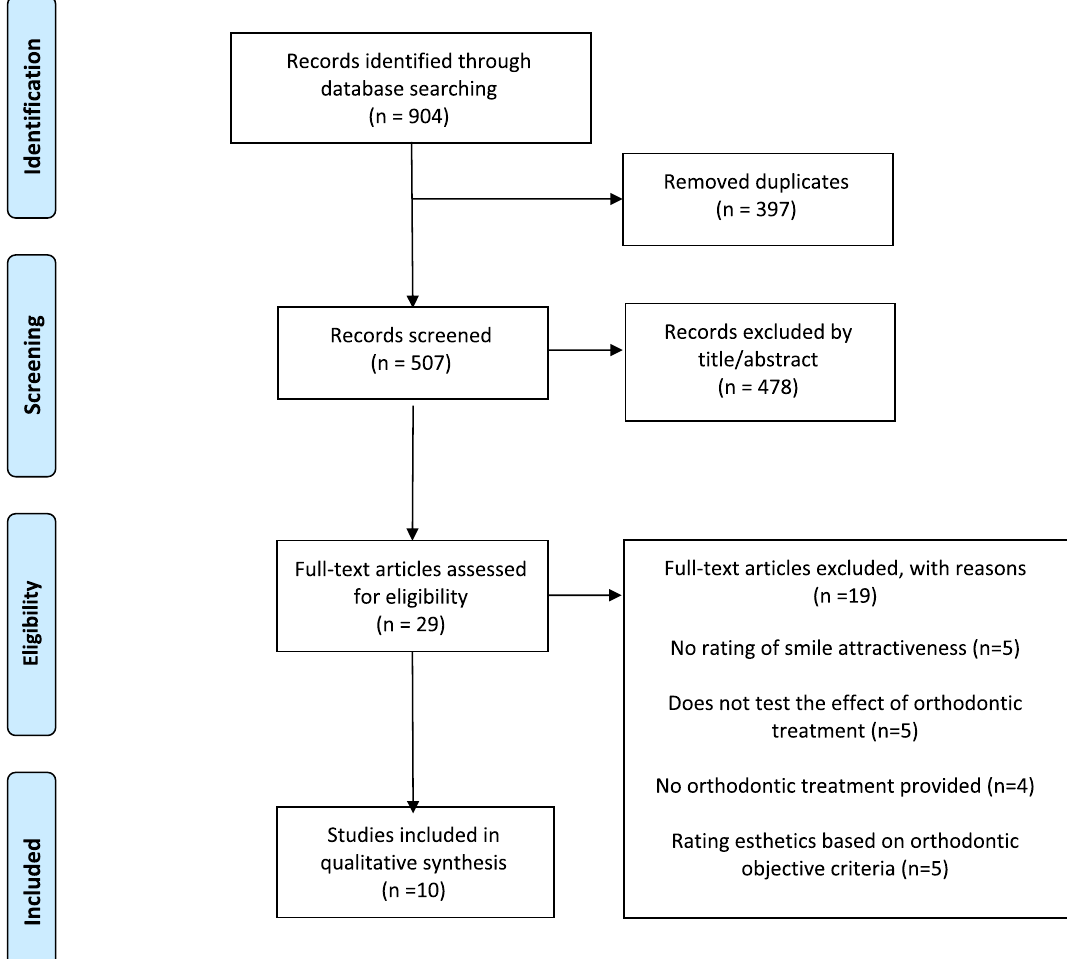
Fig. 1 Flow diagram for the selection of studies according to PRISMA. (Diagram from: Moher D, Liberati A, Tetzlaff J, Altman DG, The PRISMA Group (2009). Preferred Reporting Items for Systematic Reviews and Meta-Analyses: The PRISMA Statement. PLoS Med 6(7): e1000097. https:// doi. org/ 10. 1371/ journ al. pmed1